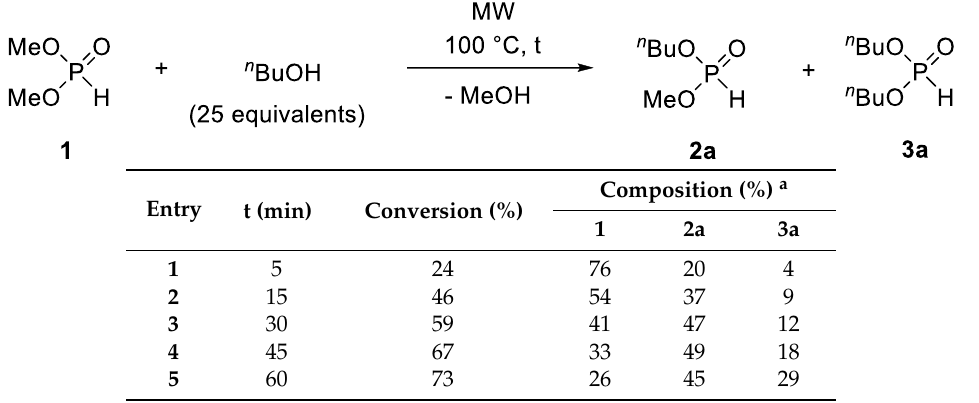
Table 4. Comparative experiments for the alcoholysis of dimethyl H -phosphonate (DMP) with n BuOH in a batch MW reactor.